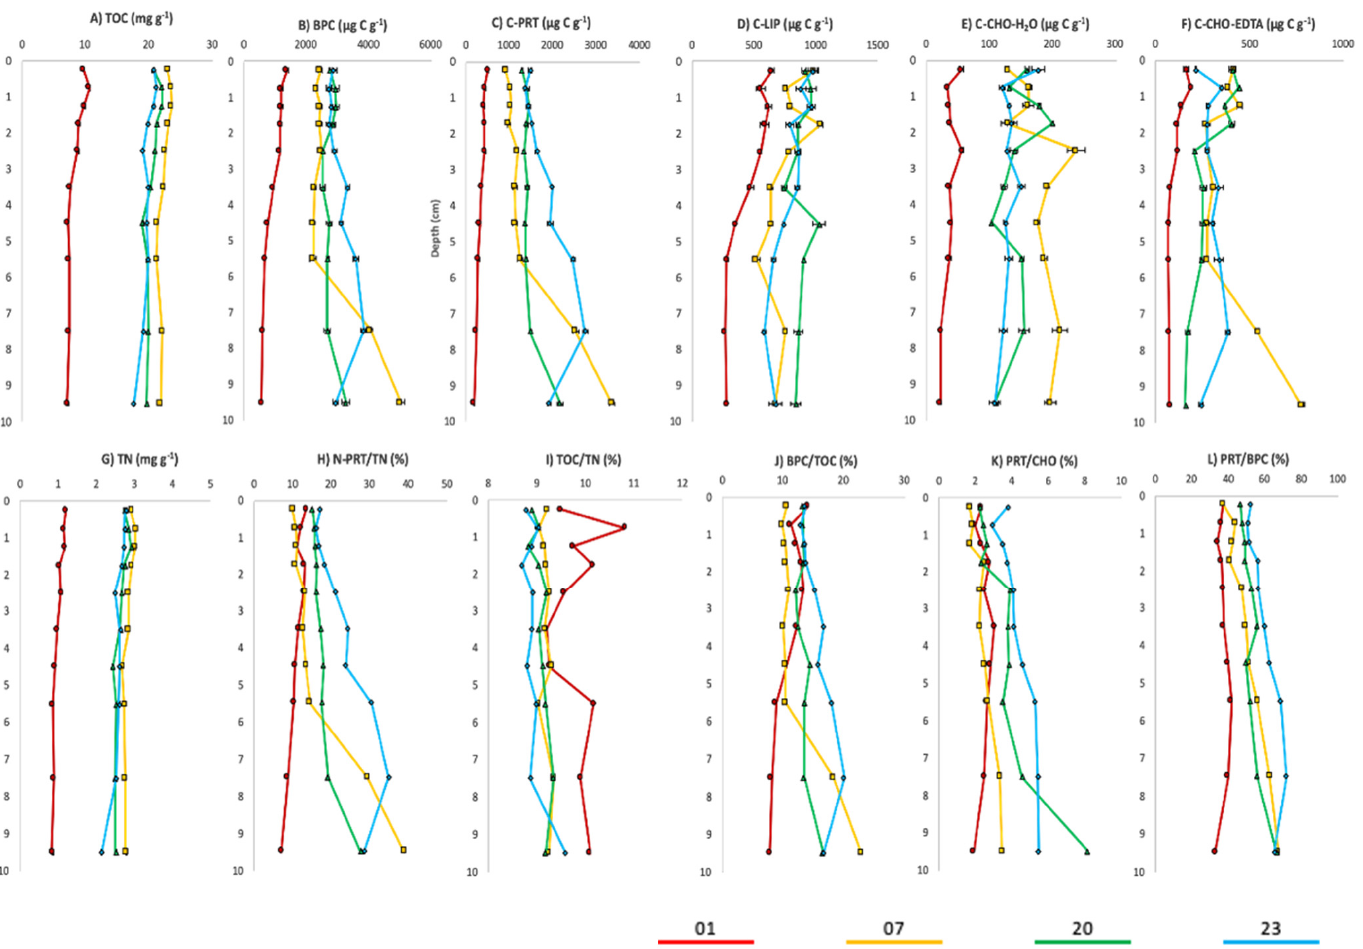
Figure 3. Chemical and biochemical elemental analyses of ( A ) Total Organic Carbon (TOC) (mg g − 1 ), ( B ) biopolymeric carbon (BPC, µ g C g − 1 ), ( C ) protein (C-PRT, µ g C g − 1 ), ( D ) lipid (C-LIP, µ g C g − 1 ), ( E ) carbohydrate (C-CHO H2O , µ g C g − 1 ), ( F ) carbohydrate (C-CHO EDTA , µ g C g − 1 ), ( G ) Total Nitrogen (TN) (mg g − 1 ), ( H ) Protein Nitrogen/Total Nitrogen ratio (N-PRT/TN), ( I ) Organic Carbon/Total Nitrogen ratio (TOC/TN), ( J ) BPC/TOC ratio, ( K ) PRT/CHO ratio and ( L ) PRT/BPC ratio. Red line: station 01; yellow line: station 07; green line: station 20; blue line: station 22.